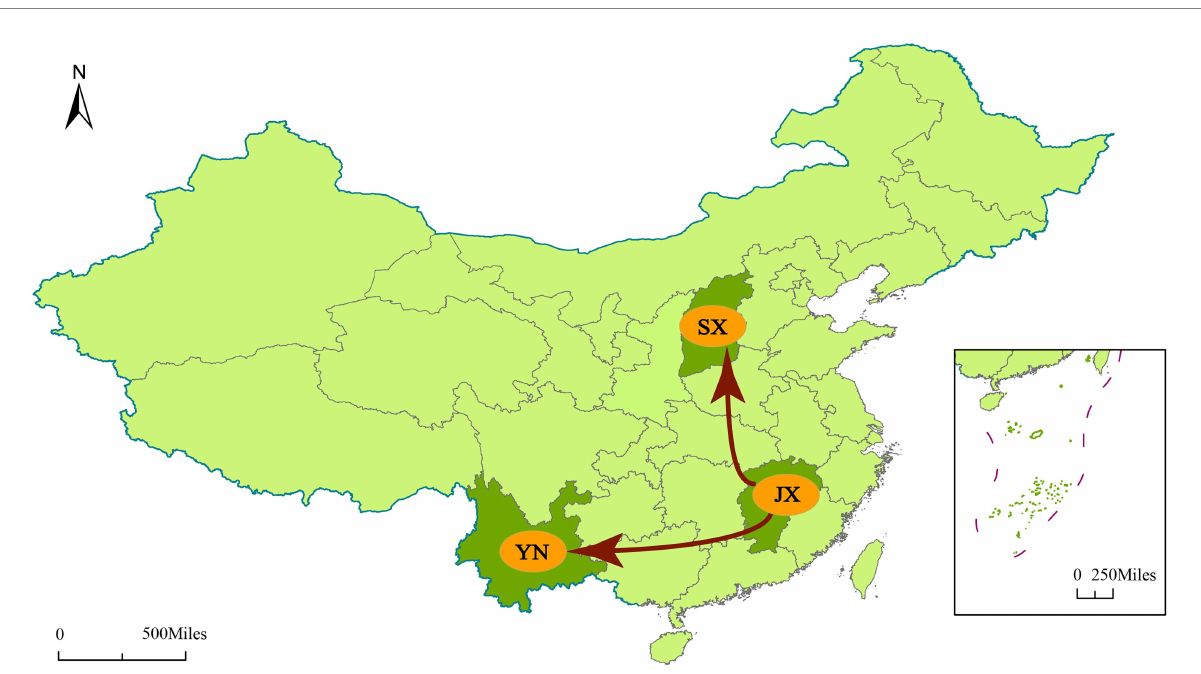
FIGURE 3 Spatial spread links of CVA12 between sampling locations in Mainland China. The figure shows only the state transitions with supported BF ≥ 3 and posterior mean value ≥ 0.5. Red arrow, Very strongly supported rates with BF ≥